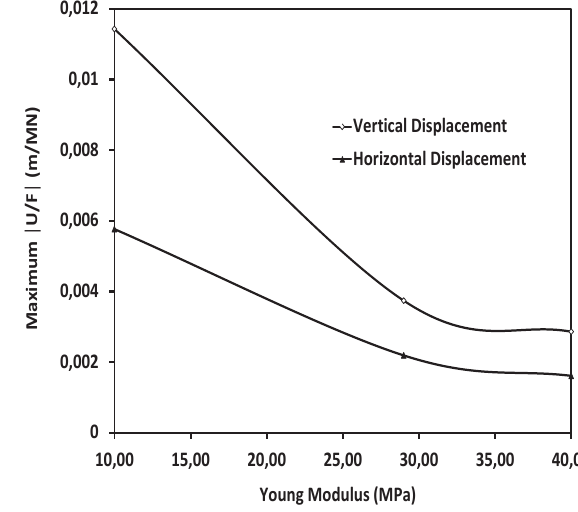
Figure 17: Vertical displacement amplitude │ U/F │ .̶ Figure 17 Vertical displacement amplitude │U/F│̶ Figure 17 Vertical displacement amplitude │U/F│̶